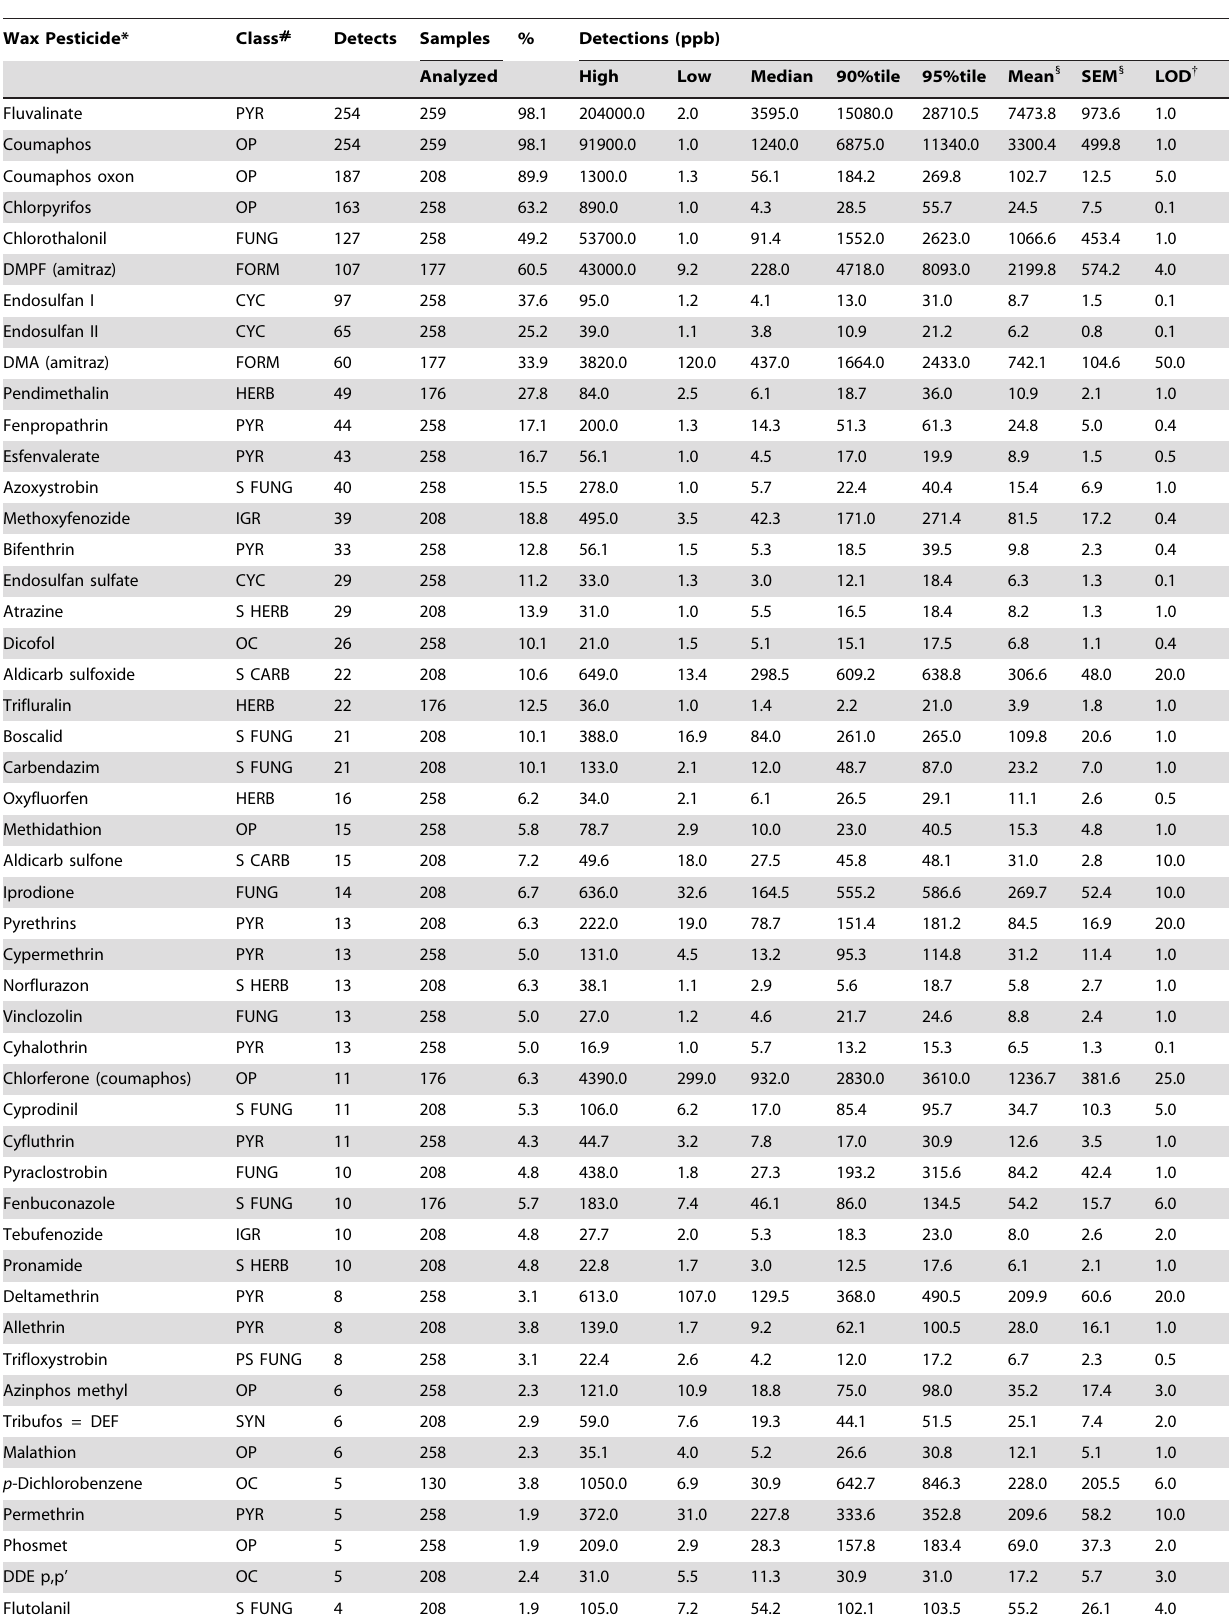
Table 1. Summary of pesticide detections in wax samples from North American honey bee colonies.